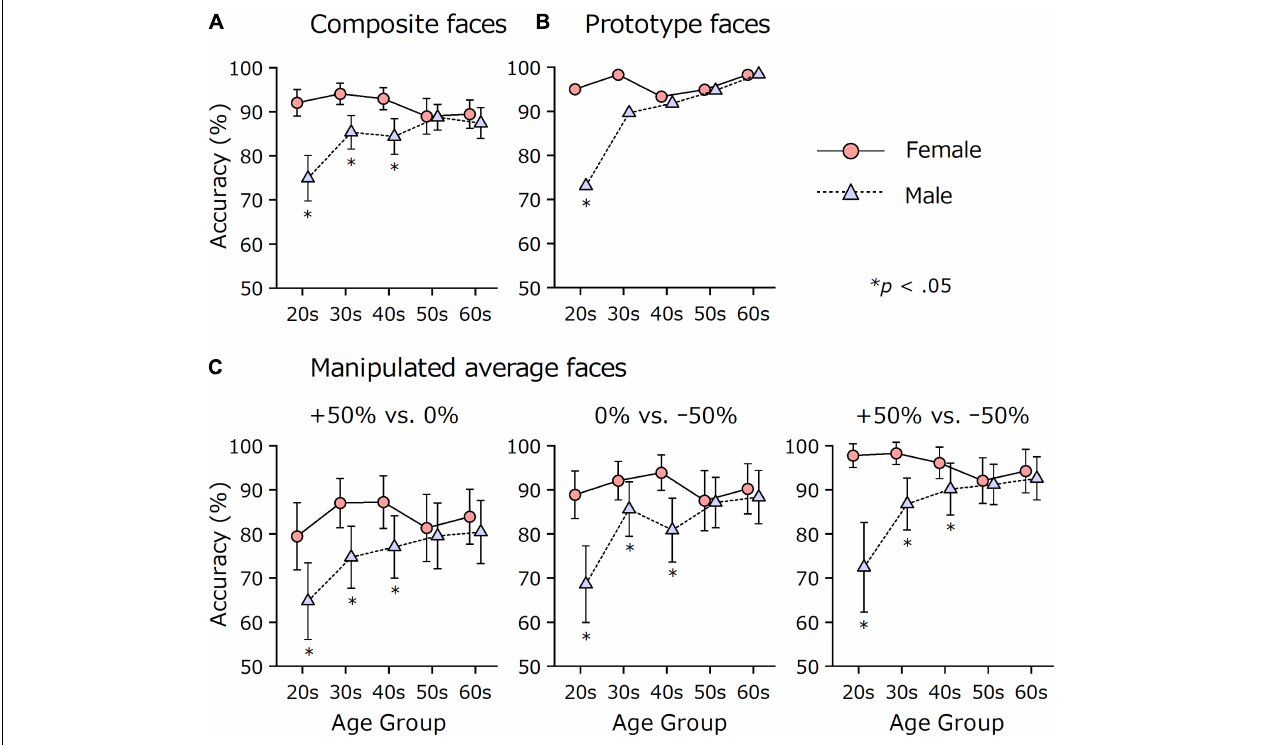
FIGURE 6 | Sex and age differences in cuteness discrimination accuracy. Participants ( N = 587) were asked to choose the cuter face from the pair. Error bars indicate 95% confidence intervals. Note that the accuracy for prototype faces has no error bar because the value indicates the proportion of respondents who answered correctly on a single trial. (A) The data on 50 composite faces. (B) The data on prototype faces. (C) The data on manipulated average faces.